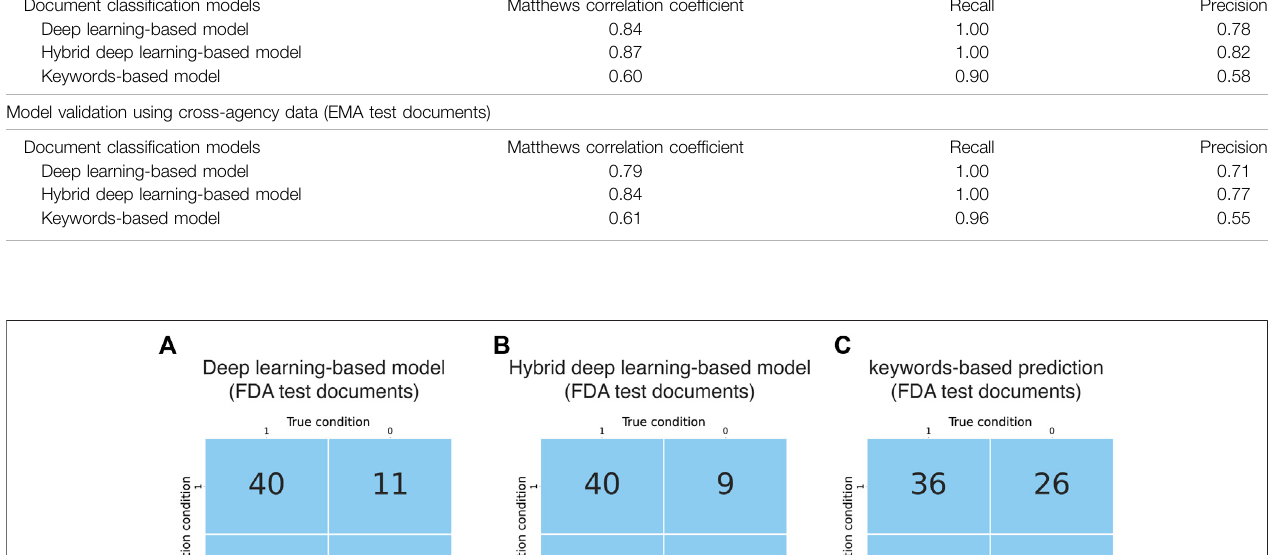
TABLE 2 | Model evaluation and validation using cross-agency data. Model evaluation using FDA test documents Document classi fi cation models